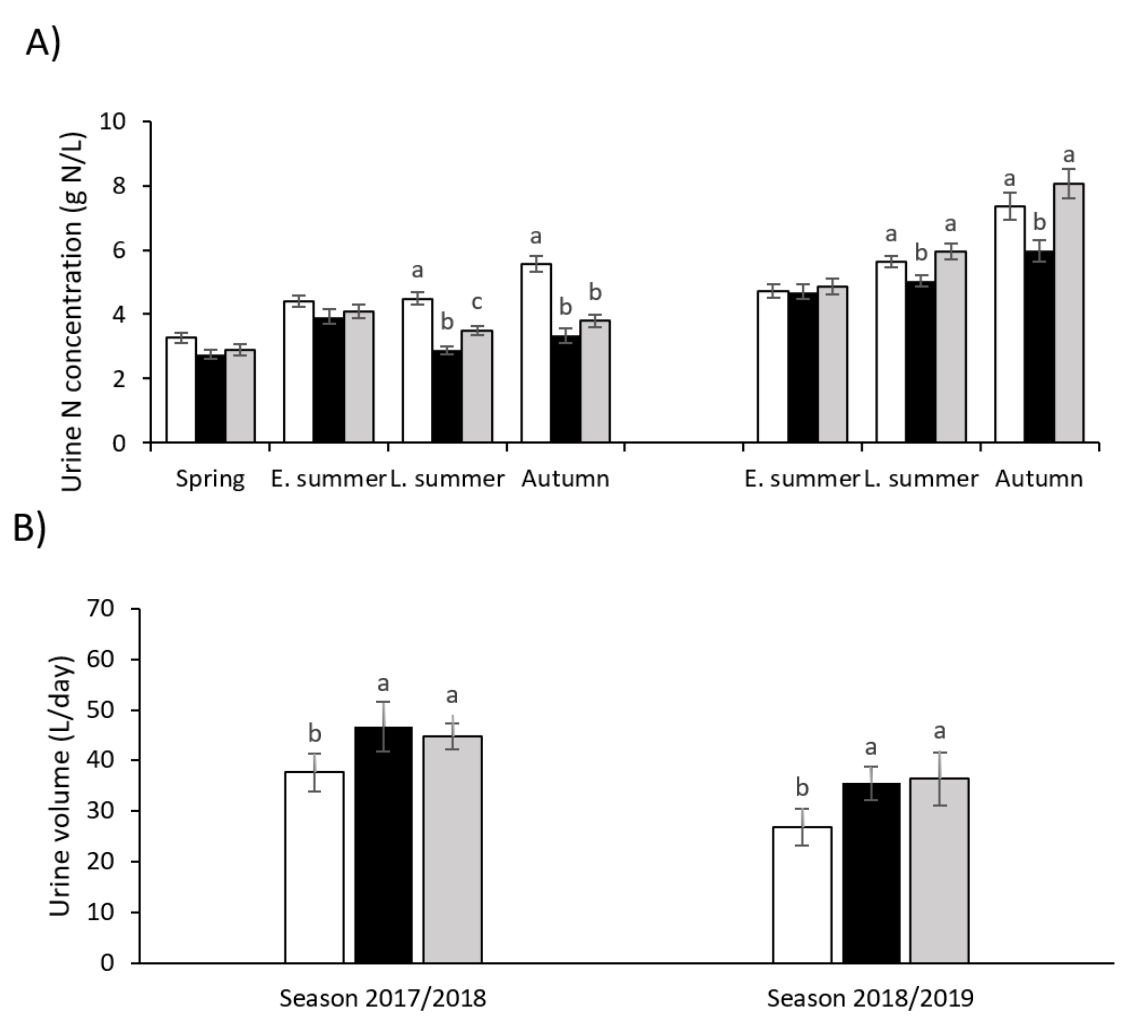
Figure 1. ( A ) Urinary N concentration and ( B ) urine volume from lactating dairy cows grazing plantain (black), plantain–clover (grey), and ryegrass–white clover (white) pastures in spring, summer (early and late), and autumn over two years. a,b,c letters indicate values in each season that are significantly different ( p < 0.05).